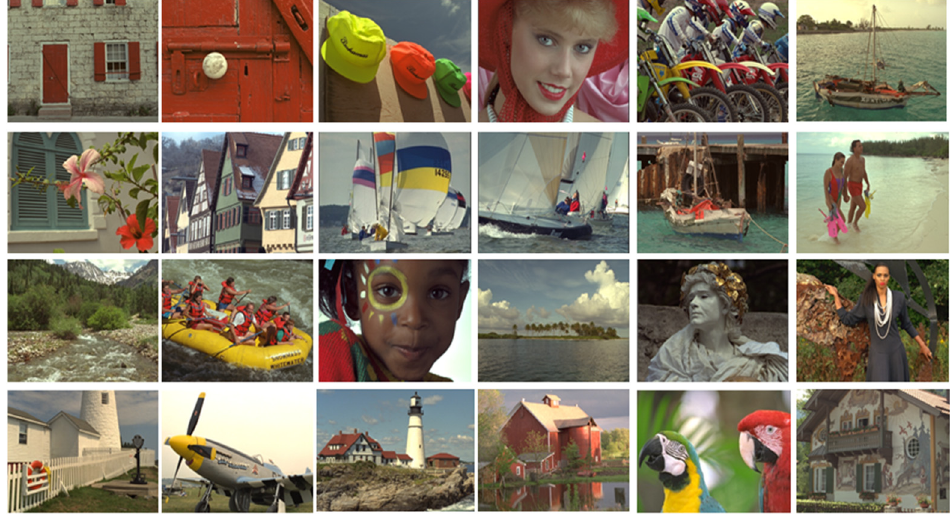
Figure 13. Small copies of test images.